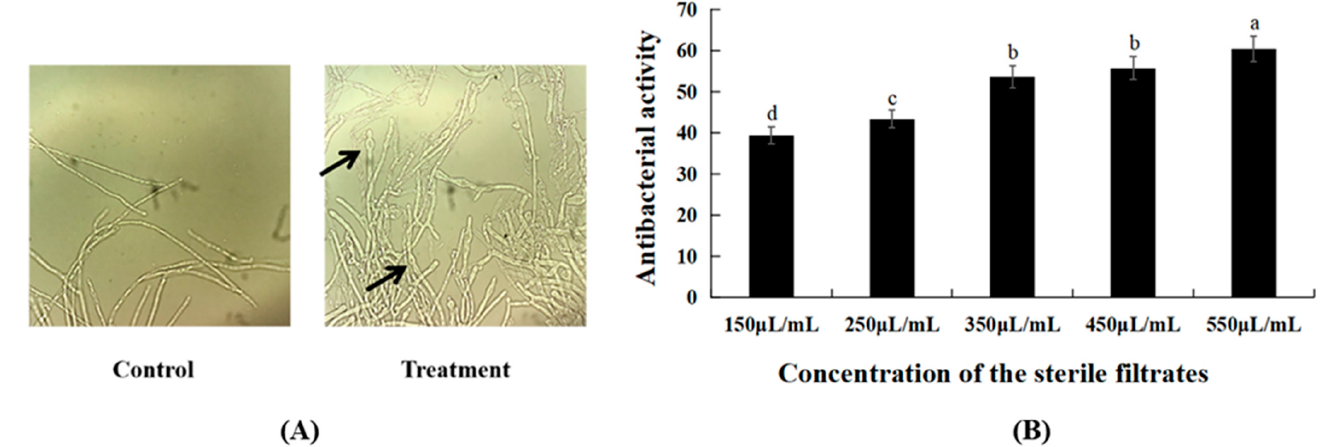
Figure 1. ( A ) The number of mycelia in the treated group was observed to increase under the mi- croscope (×40); arrow indicates inflated hyphae; ( B ) The independent regression equation is y = 0.9805x + 2.5565. The correlation coefficient R 2 = 0.9491. The EC 50 = 310.6 µL/mL. The error bar represents the standard error of the means of the replicates ( n = 3). Different letters above the bars indicate significant differences at p < 0.05 (according to Duncan’s multiple range test).